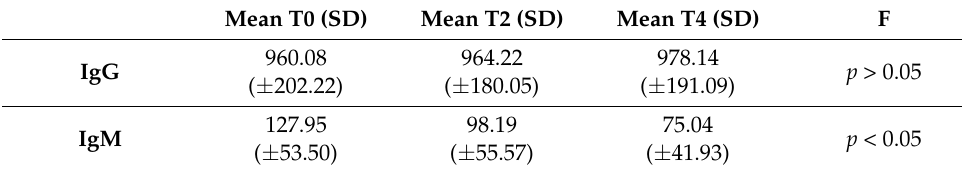
Table 3. Immunoglobulins in MS patients.